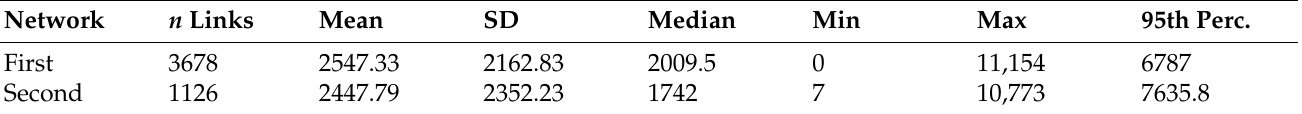
Table 4. Descriptive statistics for the weight of both networks according to the node-based model.